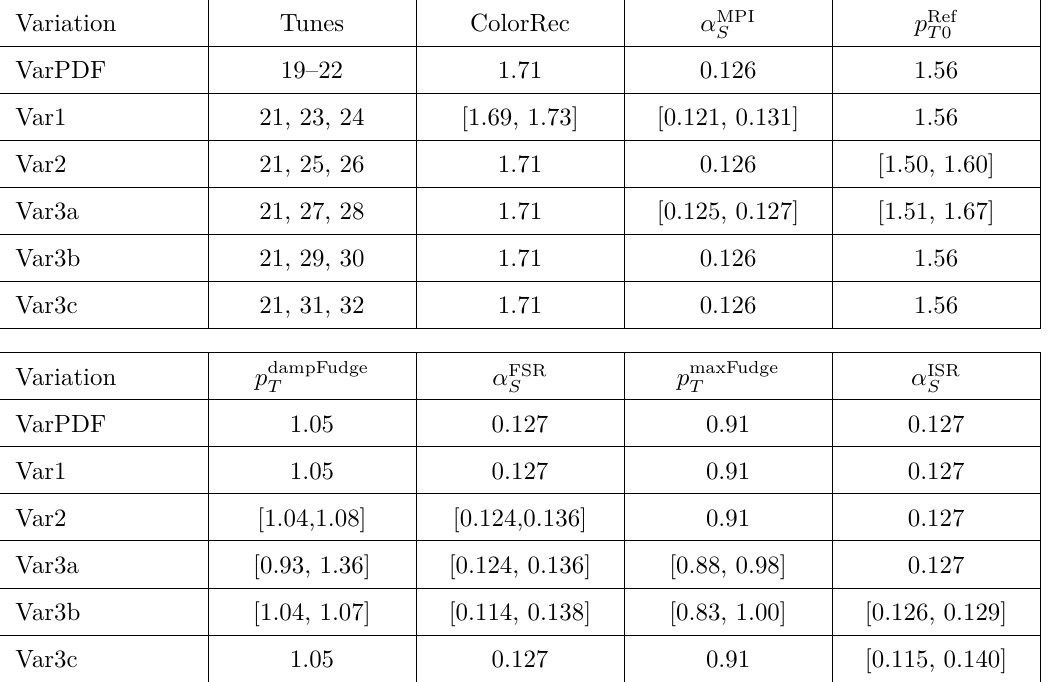
color reconnection ( ColourReconnection:range ), the strong coupling constant for multiparticle interactions α MPI